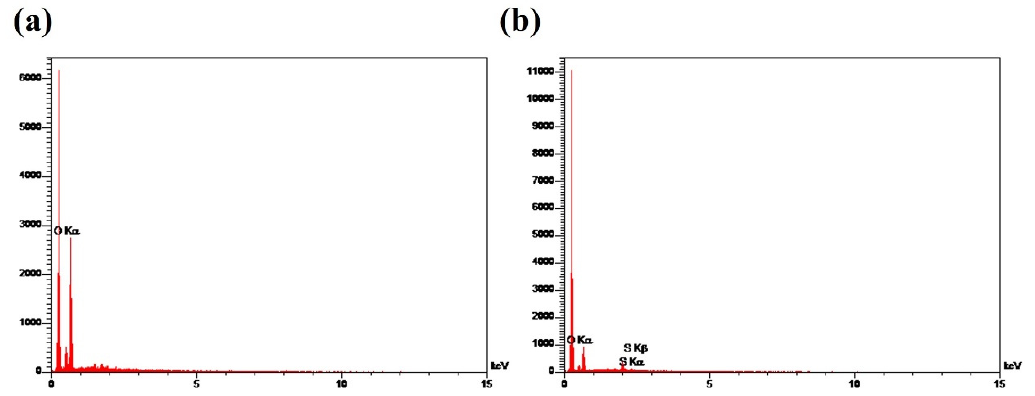
Figure 7. EDS patterns recorded for the graphite electrodes, cycled in ( a ) the electrolyte without the PVS, and ( b ) the electrolyte with 1 wt % of the PVS. PVS, and ( b ) the electrolyte with 1 wt % of the